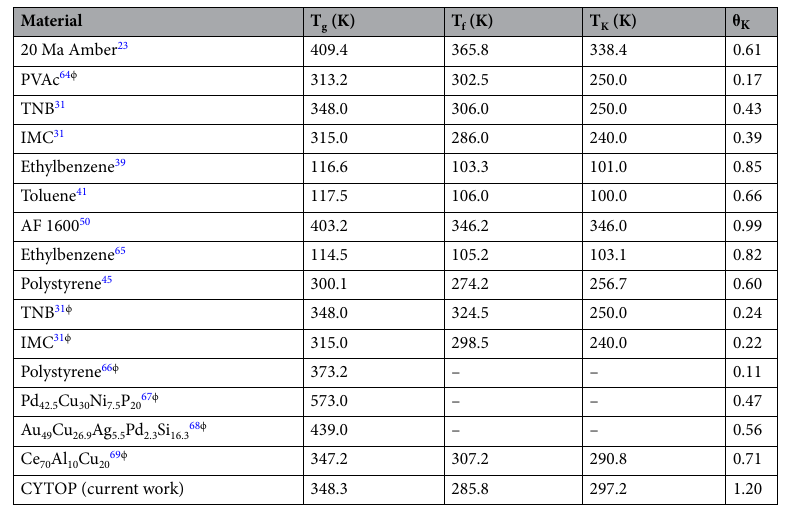
Table 2. Summary of some literature results for stability of glasses made by different paths. The symbol ‘ ϕ’ indicates data captured by conducting aging experiments. PVAc was annealed at 298 K for 2 months; TNB was annealed at 328 K for 15 days; IMC was annealed at 295 K for 210 days; Polystyrene was annealed at 358 K for 365 days; Au 49 Cu 26.9 Ag 5.5 Pd 2.3 Si 16.3 was annealed at 373 K for 100,000 s; Pd 42.5 Cu 30 Ni 7.5 P 20 was annealed at 540 K for 10,000 min;